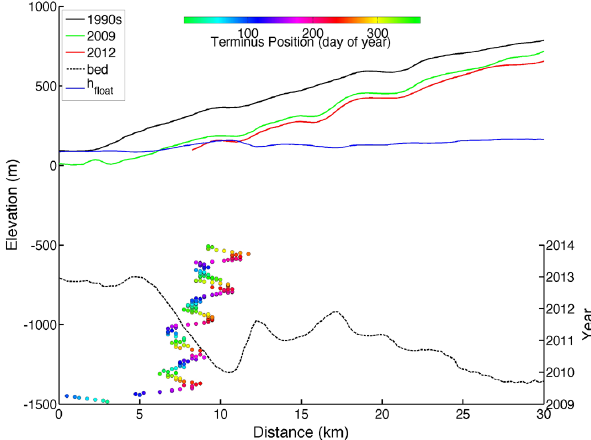
Fig. 3. Surface and bed elevations in the near-terminus region of Jakobshavn Isbræ along the profile shown in Fig. 1. Terminus po- sition ( x axis) is shown as a function of time (right y axis) with colour to indicate day of year (see also same data in Fig. 2). Surface elevations were determined (Joughin et al., 2012a) by interpolating data collected by NASA’s Airborne Topographic Mapper (ATM) in the 1990s, 2009, and 2012 as part of Operation IceBridge and its predecessor missions (Krabill et al., 2004). Bed elevations were in- terpolated from a gridded map of radar depth soundings produced by the Center for Remote Sensing of Ice Sheets (CReSIS)(Li, 2009; Van der Veen et al., 2011). Multiple versions of the DEM exist, but based on comparison with other data sets our preferred version is the one located at (ftp://data.cresis.ku.edu/data/grids/old_format/2008_